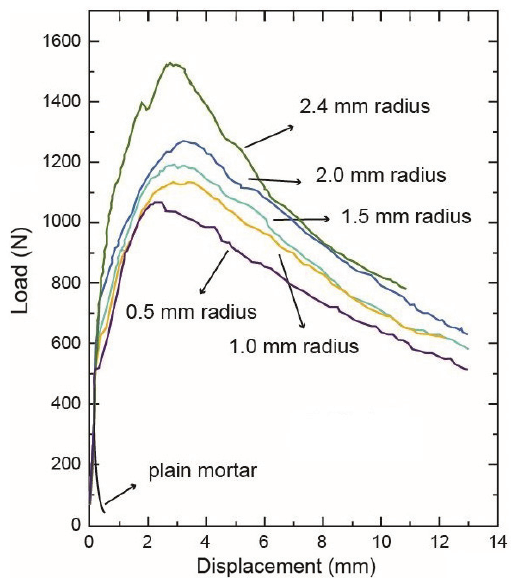
Figure 3. Load-displacement curves of the 45 mm fiber composite mortar.